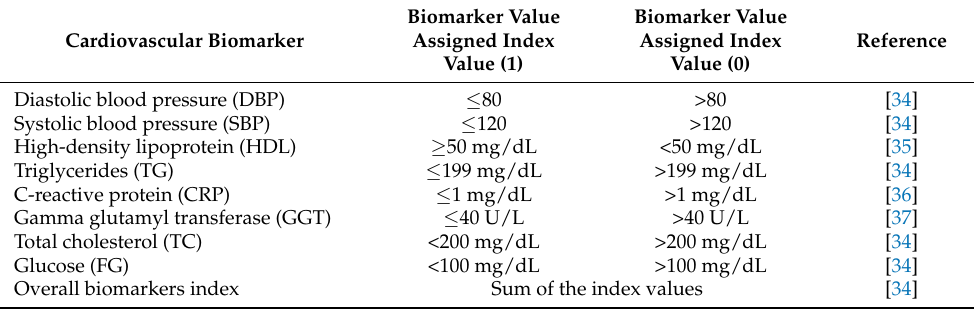
Table 1. Overall cardiovascular biomarkers index